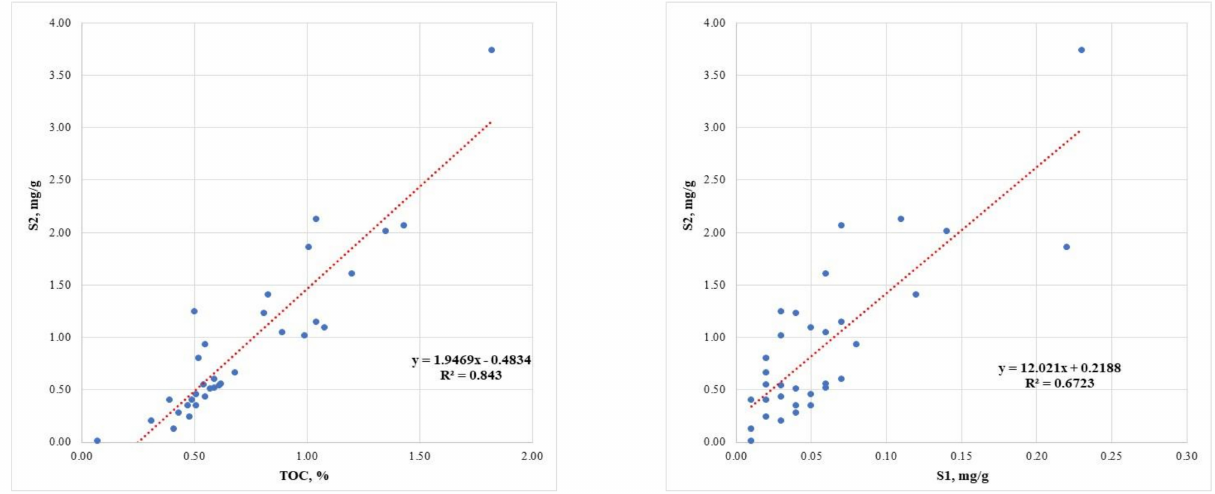
Figure 16. S 2 (mg HC/g rock) variation vs. TOC (wt%, left ) and vs. S 1 (mg HC/g rock, right